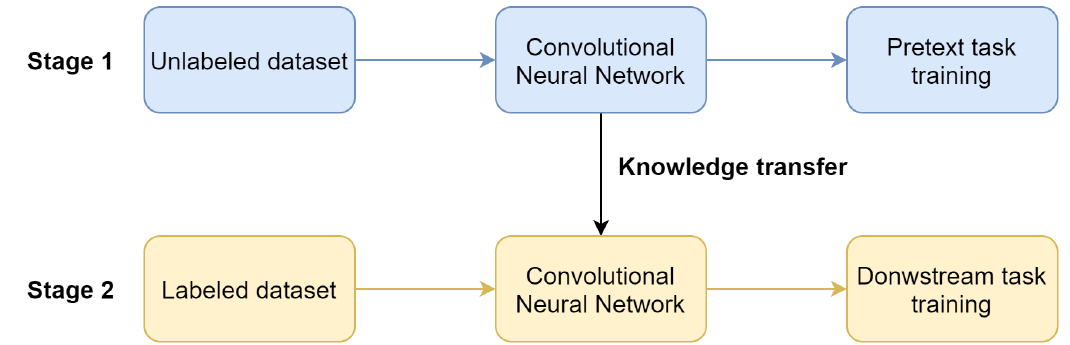
Figure 1. The general pipeline of self-supervised learning. An unlabeled dataset is used to pretrain the network (Stage 1), that is then used to train the network on labeled dataset (Stage